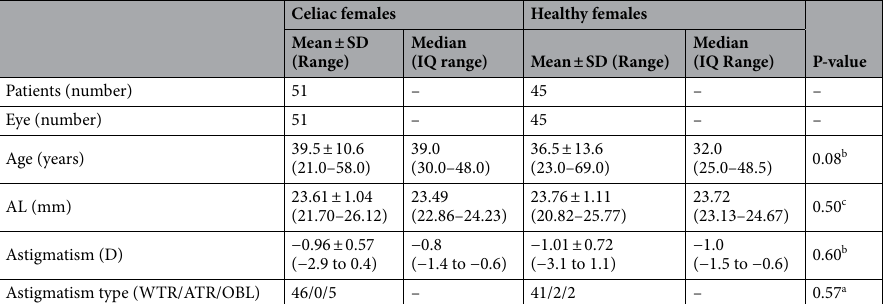
Table 3. Demographic characteristics of the two female groups. a Chi-square test with Yates correction. b